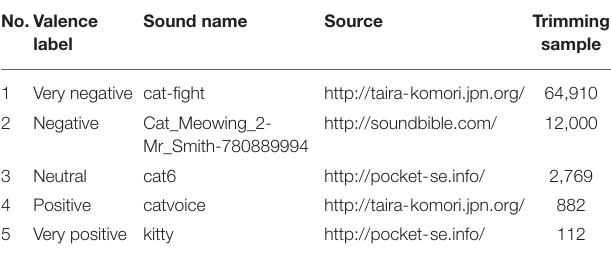
TABLE 1 | Properties of affective sounds.